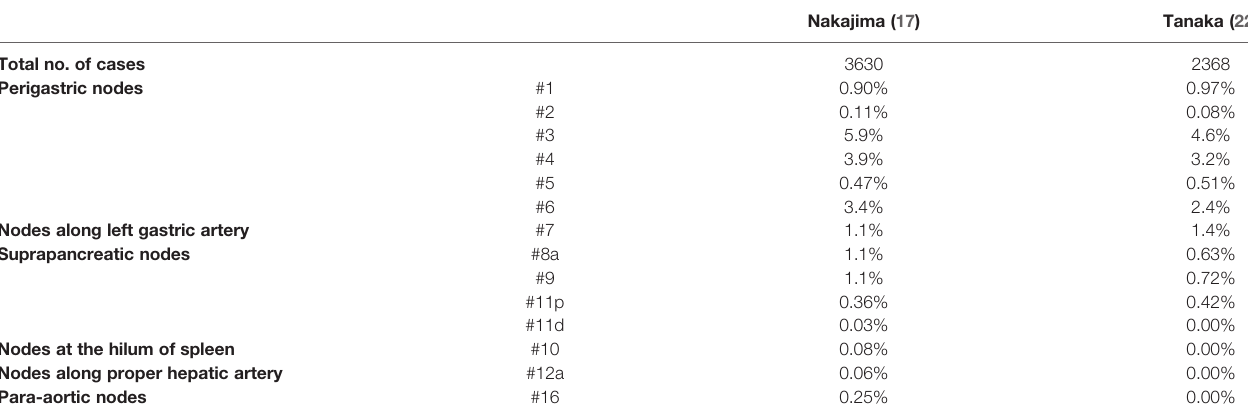
TABLE 1 | The precise incidence of nodal metastasis of early gastric cancer in previous studies with large number of cases.